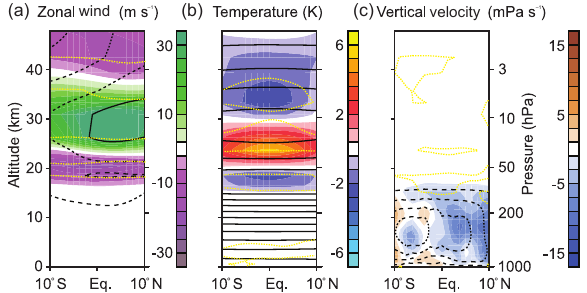
Figure 5. Composite fields (shading) and climatologies (contours) of ERA-Interim for boreal winter for easterly minus westerly QBO phases for zonal averages within 120–160 ◦ E for (a) zonal wind (contours: − 50 to 50ms − 1 in steps of 20ms − 1 ), (b) temperature (contours: 200 to 300K in steps of 10K) and (c) omega ( − 70 to 70Pas − 1 in steps of 20Pas − 1 ) in December–February using the 70hPa QBO definition. Yellow dashed lines indicate significant dif- ference ( p = 0 .